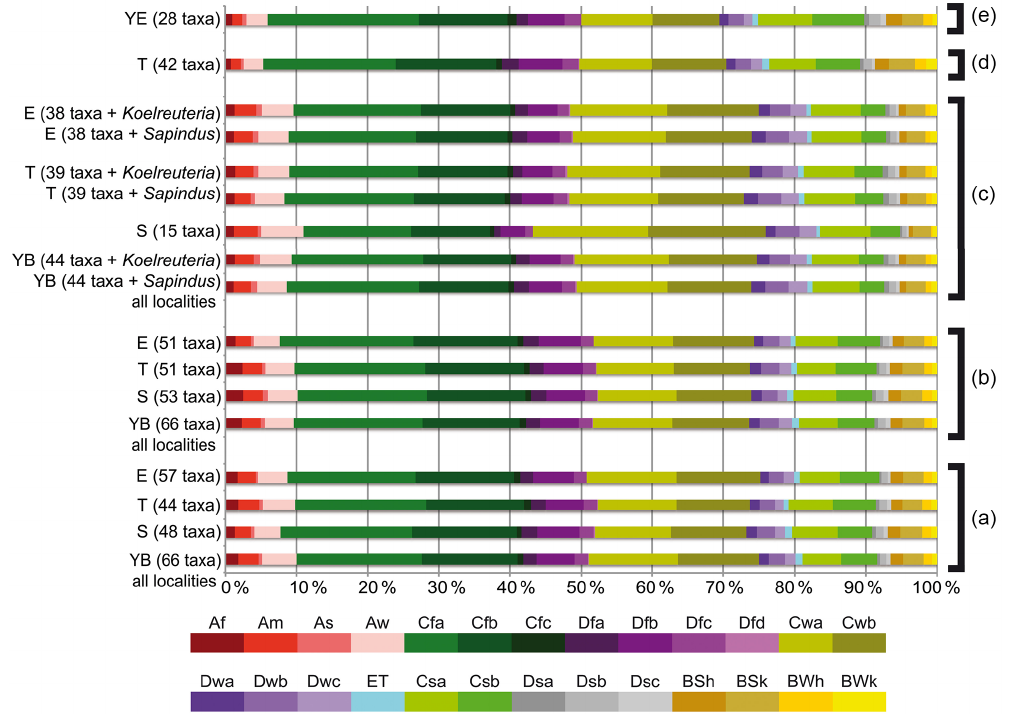
Figure 5. Köppen signals for the Yata˘gan Basin flora. (a) Pollen zone (PZ) 1 (MN6; 14.95–13.9Ma) of the Eskihisar (E), Tınaz (T), and Salihpa¸salar (S) localities and the combined signal of all present taxa from PZ 1 of the three Yata˘gan Basin localities (YB). (b) PZ 2 (MN6) of E, T, S, YB. (c) Macrofossil (MF) assemblages (same level as PZ 2) of E, T, S. (d) PZ 2/3 of T (younger than Yeni Eskihisar vertebrate locality). (e) Yeni Eskihisar vertebrate locality pollen assemblage (MN7/8, younger than radiometric age 13.2Ma). Diagrams based on extracted data from Supplement